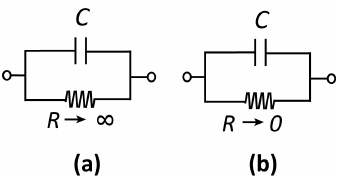
Figure 1. Equivalent circuits for ( a ) a polarizable and ( b ) a non-polarizable interface.